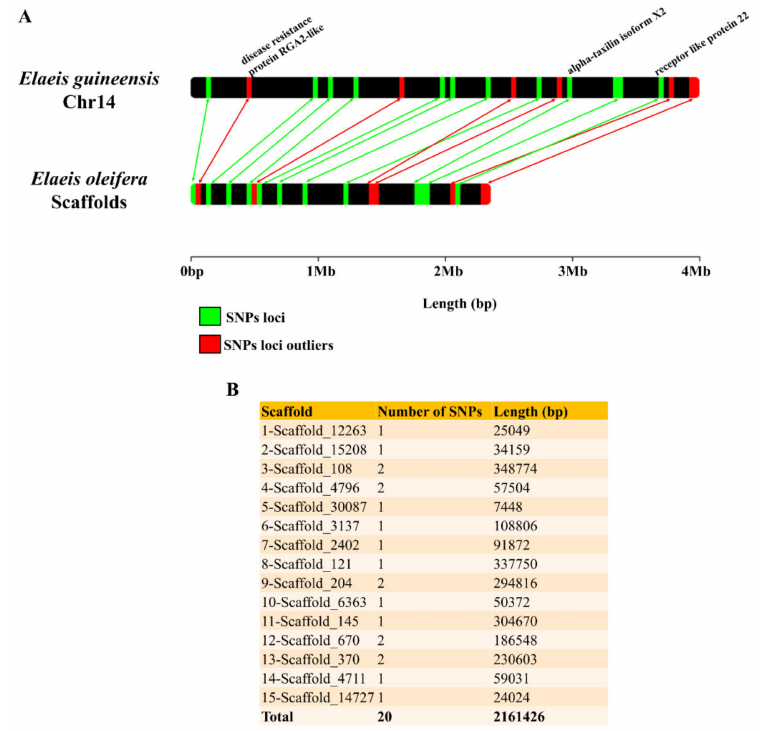
Figure 3. Synteny and collinearity of 20 SNPs loci between E. guineensis and E. oleifera ( A ). Table with the sizes of scaffolds of E. oleifera used for the comparative analysis ( B ). Visualized through the R package chromoMap.